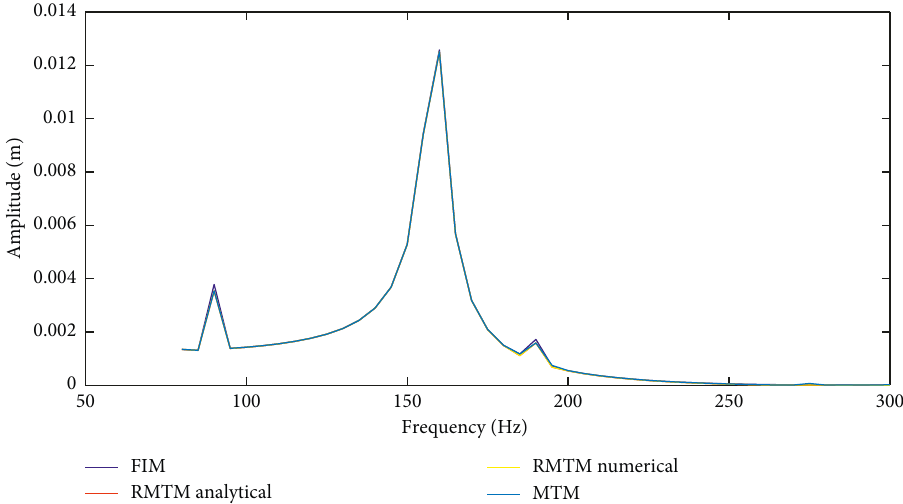
Figure 8: Amplitude-frequency response of beam end. Twenty-mode discretization: damping ratio ξ � 0 . 02 and soft impact k ∗ � 1 . 3 ( k � 1 × 10 3 N/m ) .